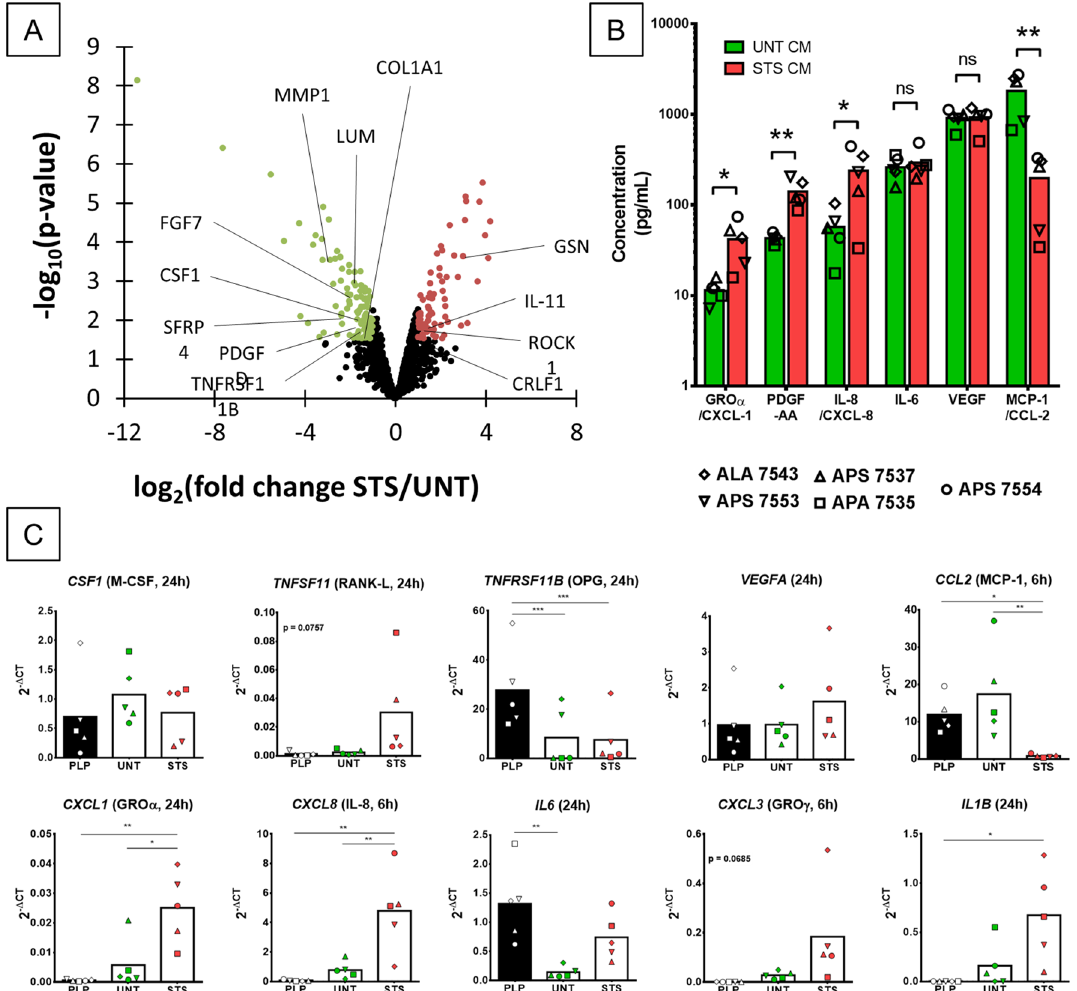
Figure 5. Soluble factors present in the media drastically change upon STS treatment. ( A ) Volcano plot displaying the differential abundance of proteins detected in STS-CM and UNT-CM by MS-based proteomics. The volcano plot represents the -log10 (p-value) on y axis plotted against the log2 (Fold Change STS/UNT) on x axis. Red and green dots represent proteins found more abundant respectively in STS-CM and UNT-CM ( p value ≤ 0.03 and fold change ≥ 2). ( B ) Quantification of cytokines concentration detected by multiplex immunoassay in UNT and STS-CM from 5 MSC donors. N = 5 independent experiments with technical duplicate. Statistical analysis by one-sided paired t-test, ns = not significant, * for p value < 0.05, ** for p value < 0.01. ( C ) Gene expression analysis in MSCs from five donors in complete media (PLP) or after 6 and 24 h in serum-free media, with (STS) or without (UNT) STS-treatment. N = 5 independent experiments. Statistical analysis by repeated measure ANOVA followed by Tukey’s multiple comparison test, * for p value < 0.05, ** for p value < 0.01, *** for p value <